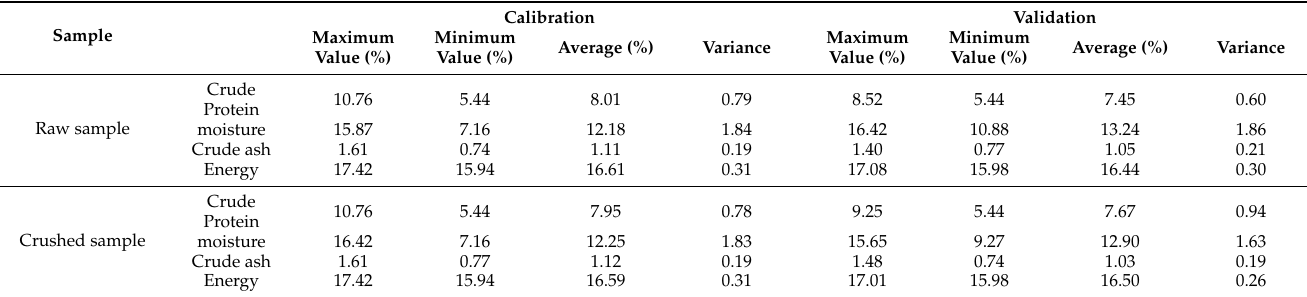
Table 1. Component statistics of raw and crushed forage maize